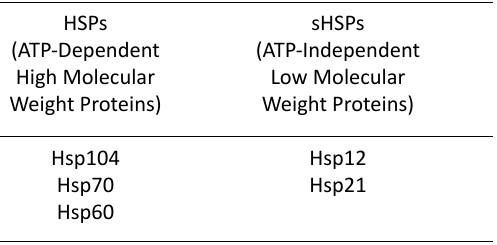
Table 1. Different types of heat shock proteins (HSPs) HSPs sHSPs (ATP-Dependent (ATP-Independent High Molecular Low Molecular Weight Proteins) Weight Proteins) Hsp104 Hsp12 Hsp70 Hsp21